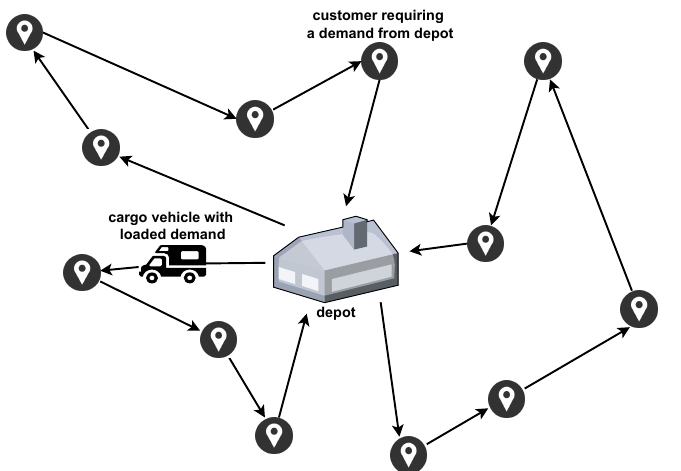
Figure 1. Network topology of a basic